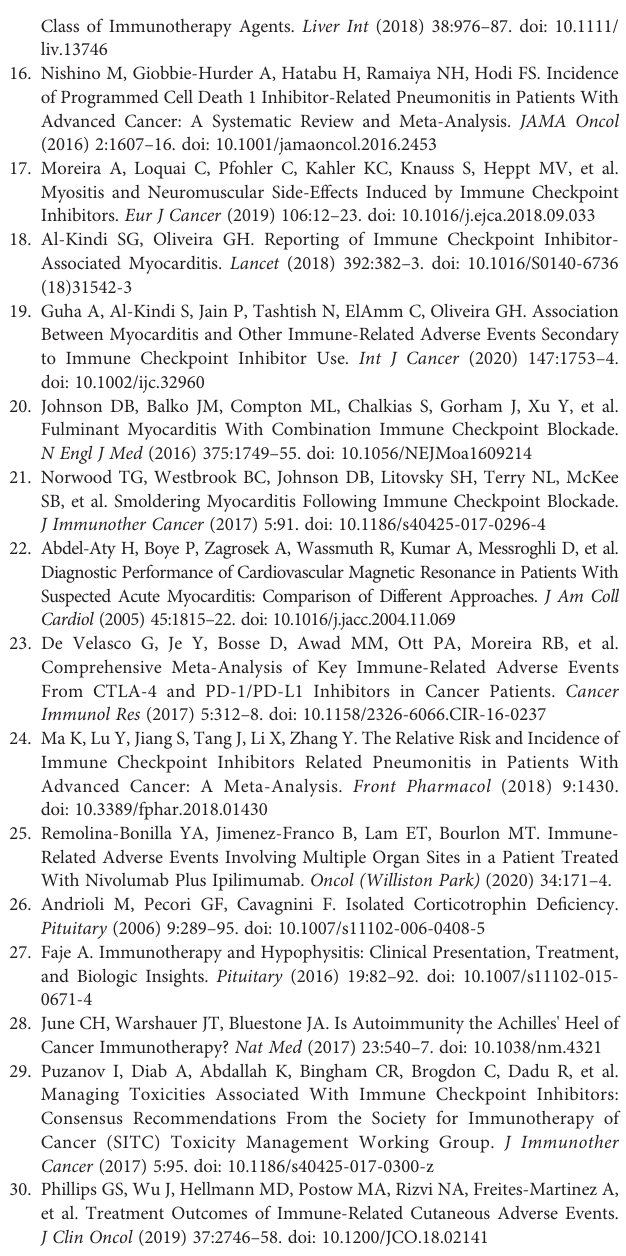
Supplementary Table 1 | Different PD-1 inhibitors monotherapy trials in patients with advanced